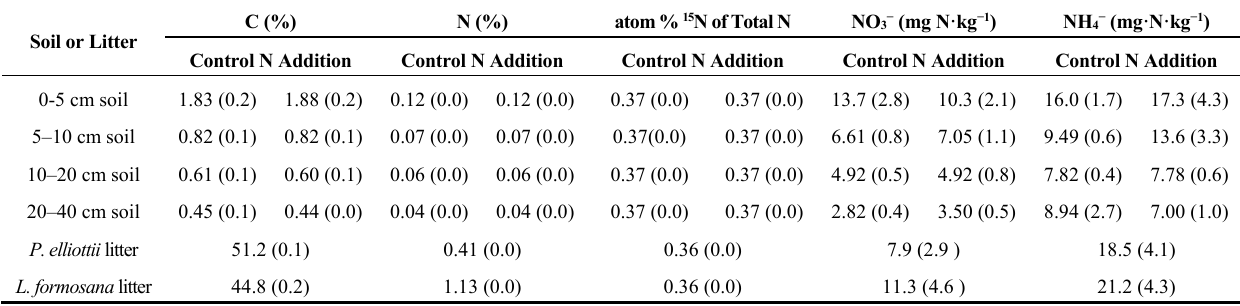
Table 1. Initial C and N concentrations in soil and litter before N addition (mean ± standard error (se); n = 8 for soil and n = 4 for